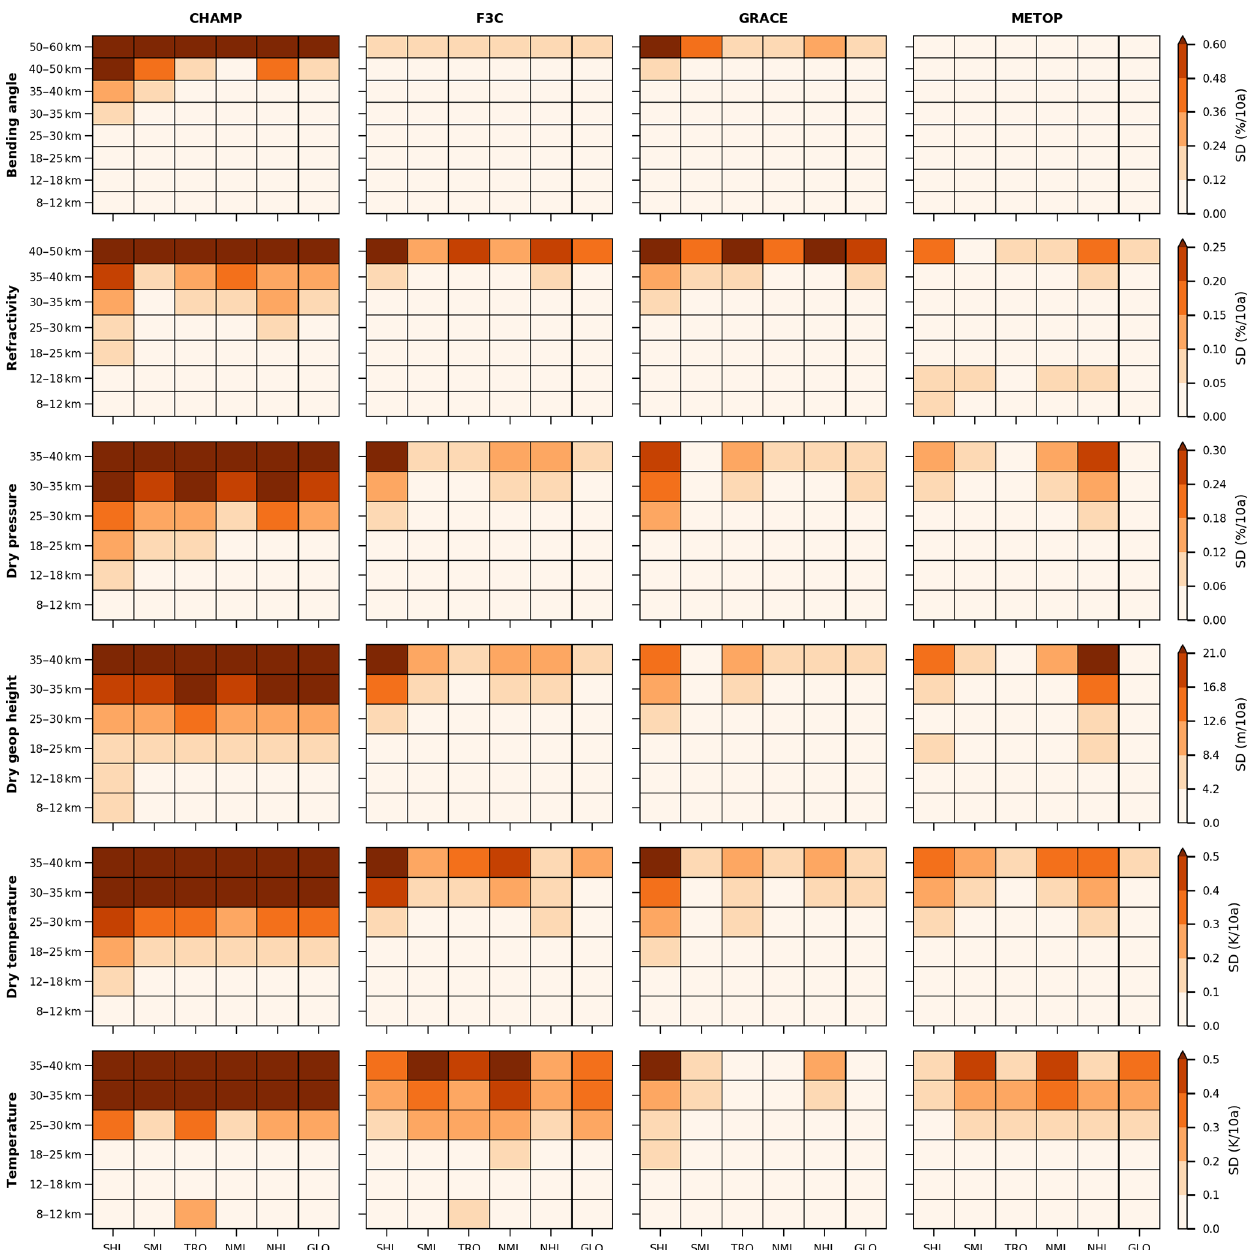
Figure 12. Overview of structural uncertainty for different RO missions: CHAMP, F3C, GRACE, and Metop (left to right). Shown is the standard deviation of individual center trends per decade based on 10 ◦ zonal medians for RO bending angle, refractivity, dry pressure, dry geopotential height, dry temperature, and temperature (top to bottom) for all latitude zones and altitude layers in the